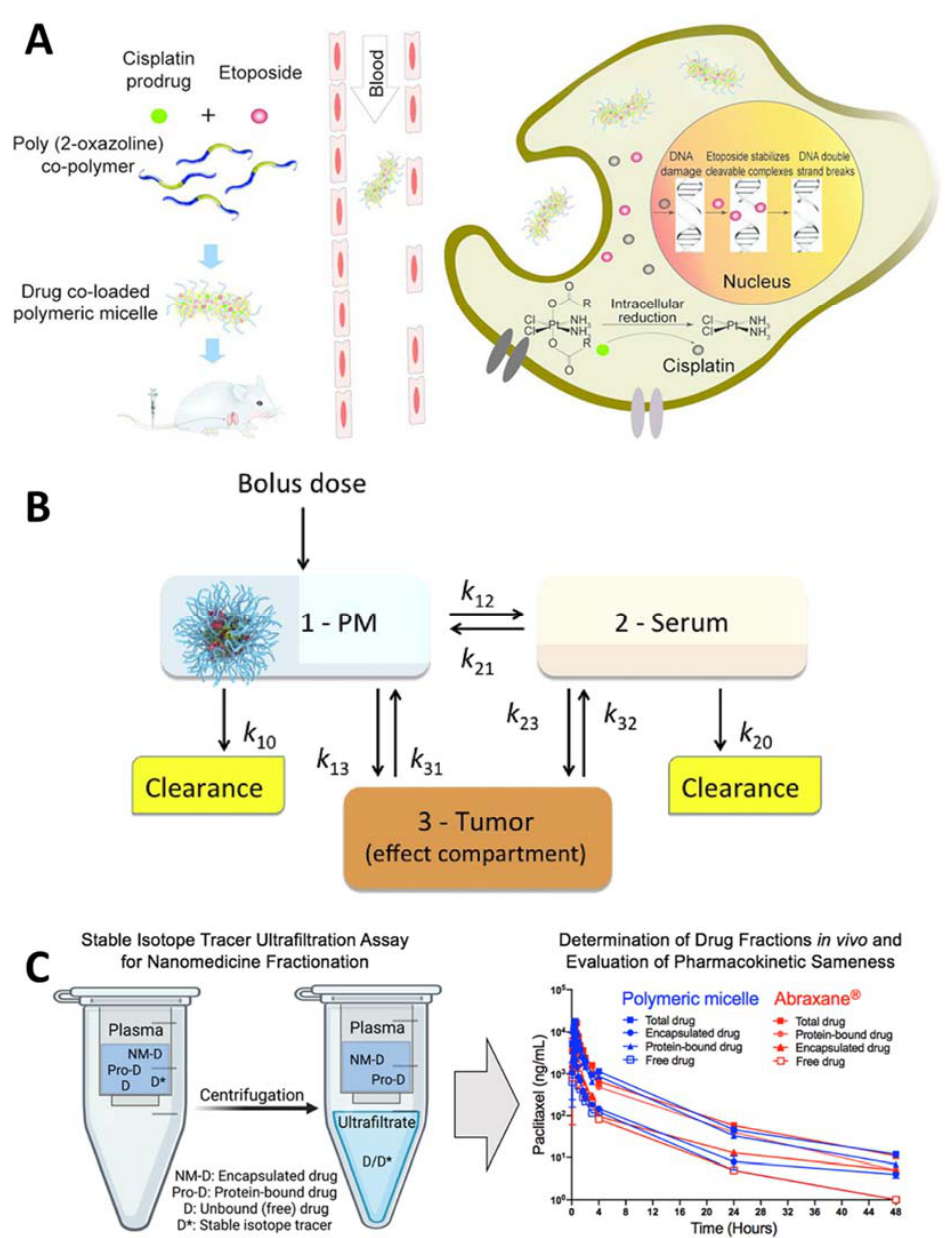
Figure 3. Examples of the application of Poly(2 ‐ oxazoline) (POx) ‐ based polymeric micelles and the assessment of their pharmacokinetics (PK) and bioequivalence profiles. In ( A ) poly(2 ‐ methyl ‐ 2 ‐ ox ‐ azoline ‐ block ‐ 2 ‐ butyl ‐ 2 ‐ oxazoline ‐ block ‐ 2 ‐ methyl ‐ 2 ‐ oxazoline) (P(MeOx ‐ b ‐ BuOx ‐ b ‐ MeOx) is used with an alkylated cisplatin prodrug to enable co ‐ formulation of etoposide (ETO) and platinum drug combination (“EP/PE”) in a single high ‐ capacity vehicle to improve the treatment of small cell lung cancer (SCLC). The drugs co ‐ loading in the micelles result in a slowed ‐ down release, improved pharmacokinetics, and increased tumor distribution of both drugs. Reprinted with permission from [58]. Copyright 2018 American Chemical Society. In ( B ) a three ‐ compartmental model describing the PMs drug delivery to a tumor . The drug is administered as bolus in the form of PMs (1) and is subsequently distributed between the serum (2) and tumor (3) compartments. The PK constants correspond to: k 12 ‐ rate of drug transfer from PMs to serum; k 21 ‐ rate of drug re ‐ capture from serum to PMs; k 13 ‐ rate of transfer (permeability) of the micellar drug to tumor; k 23 ‐ rate of transfer of the serum ‐ bound drug to tumor; k 31 and k 32 —rates of drug reabsorption from tumor to PMs and serum, respectively; and k 10 and k 20 ‐ micellar and serum ‐ bound drug clearances, respectively. The model